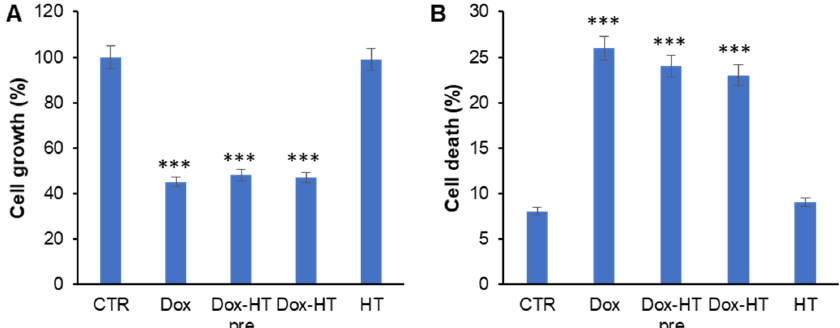
Figure 8. Effect of HT on Dox-induced antineoplastic properties in U2OS osteosarcoma cells. Number of living ( A ) and dead ( B ) cells for U2OS cells exposed to 0.1 µ M Dox for 48 h, pretreated (Dox-HT pre) and co-treated (Dox-HT) with 50 µ M HT. CTR: untreated cells; Dox: cells exposed to 0.1 µ M